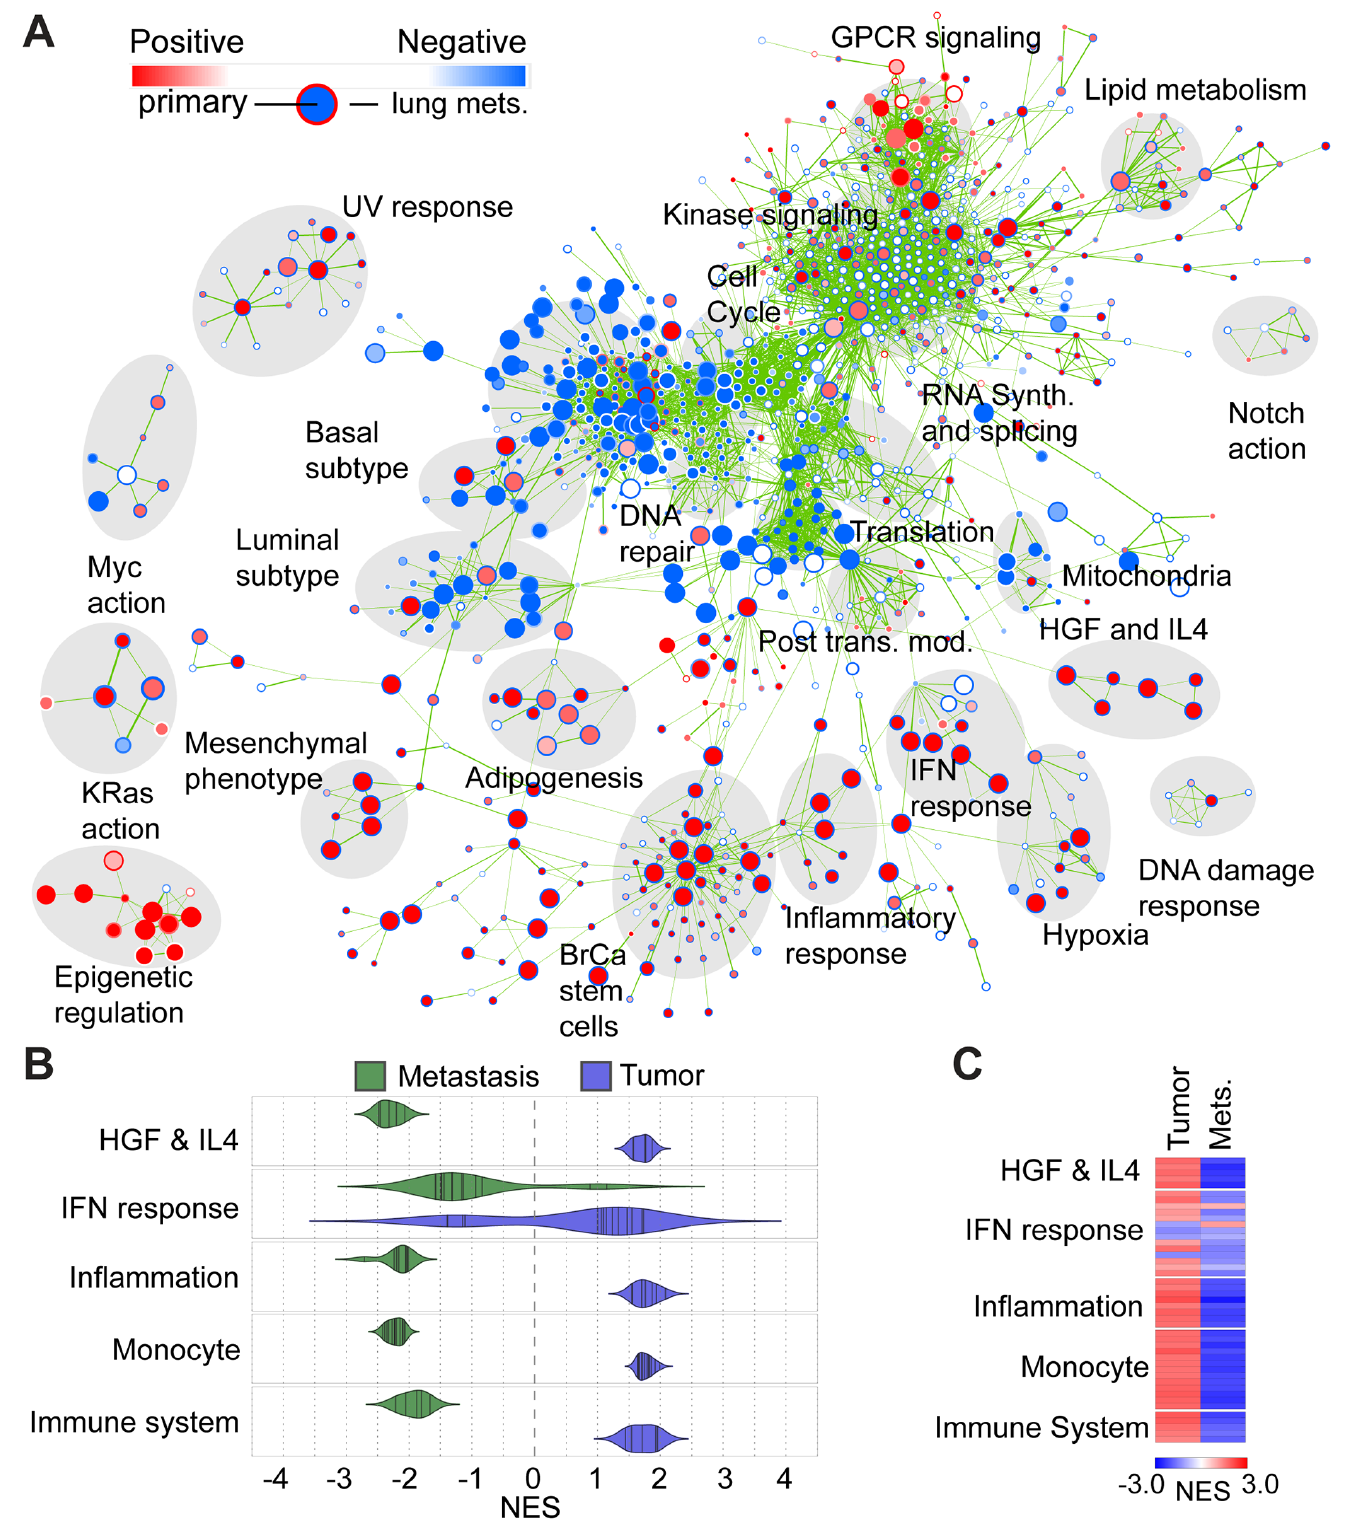
Fig 5. Patterns of gene expression driven by ELF5 in primary tumors, and comparison to subsequent changes in gene expression following metastasis. Panel A , Cytoscape Enrichment Map visualization of a gene set enrichment analysis (GSEA) of Affymetrix microarray data comparing